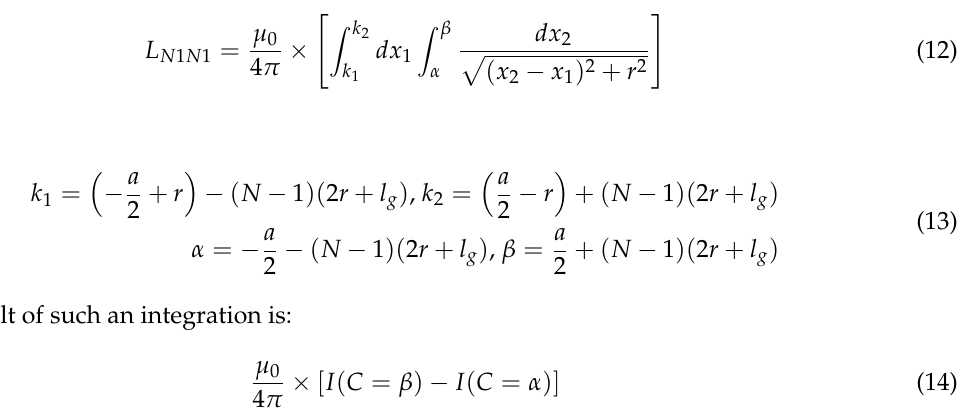
Figure 3. A multi-turn inductor with dimensions defined from the center of a wire of circular section with radius r and wound in a manner such that the air gap is uniform ( l g ) . The N -th turn “ α ” vertex has its middle edge and inner edge with vertices P N α = (cid:104)(cid:0) − a + r (cid:1) − ( N − 1 )( 2 r + l g ) , and P N α i = 2